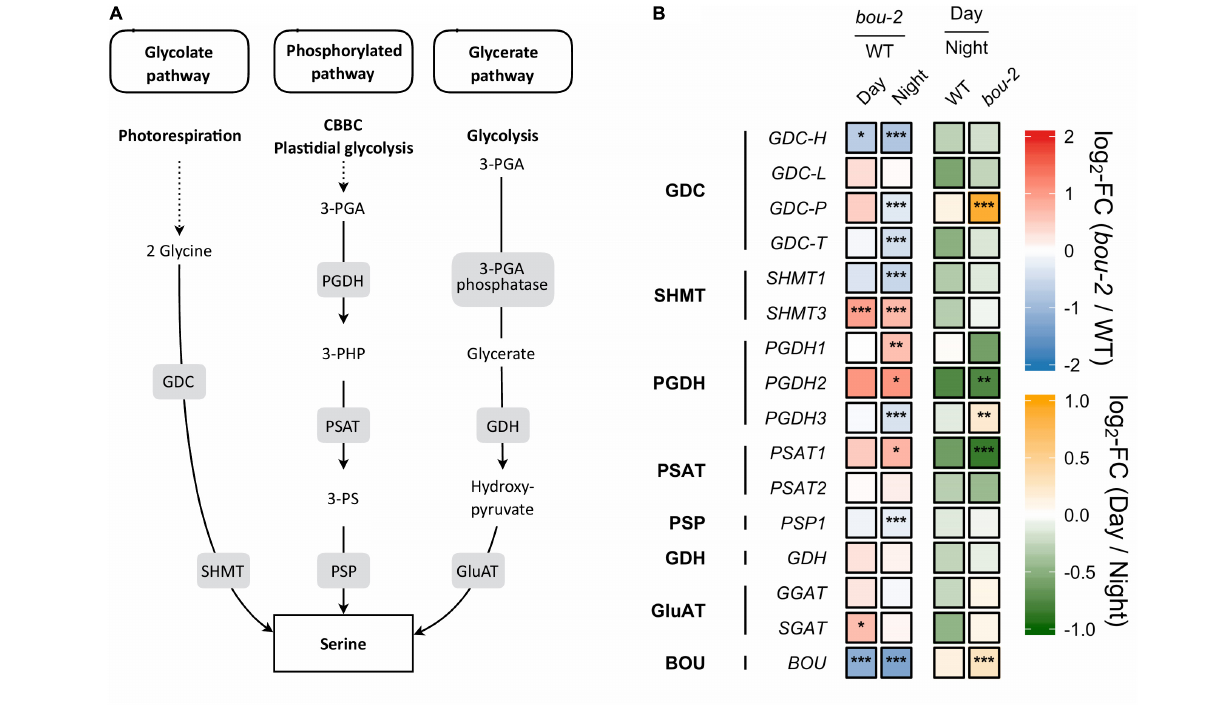
FIGURE 2 | Photorespiratory and non-photorespiratory pathways of serine biosynthesis. (A) Schematic presentation of three pathways of serine biosynthesis (adapted from Ros et al., 2013) (B) transcript levels ( n = 3) of genes involved in pathways depicted in panel A . Left two tiles of each gene represent the log2-fold change (FC) between the bou-2 mutant and WT plants under both day (D) and night (N) with false color code ranging from red (higher in bou-2 ) to blue (higher in WT). Right two tiles represent the log2-fold change (FC) between day and night within WT plants and bou-2 mutant with false color code ranging from green (higher at night) to yellow (higher at day). Asterisks indicate differential gene expression as determined by Sleuth ( ∗ FDR < 0.05, ∗∗ FDR < 0.01, and ∗∗∗ FDR < 0.001). Levels of BOU (A BOUT DE SOUFFLE) shown for reference. GDC, glycine decarboxylase; SHMT, serine hydroxymethyltransferase; PGDH, phosphoglycerate dehydrogenase; PSAT, 3-phosphoserine aminotransferase; PSP, 3-phosphoserine phosphatase; GDH, glycerate dehydrogenase; GluAT, hydroxypyruvate